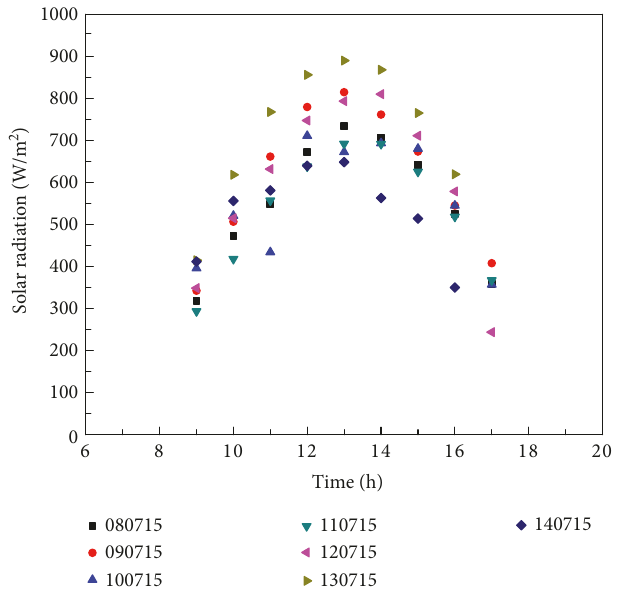
Figure 3: Incident solar irradiation from 08 July 2015 to 14 July